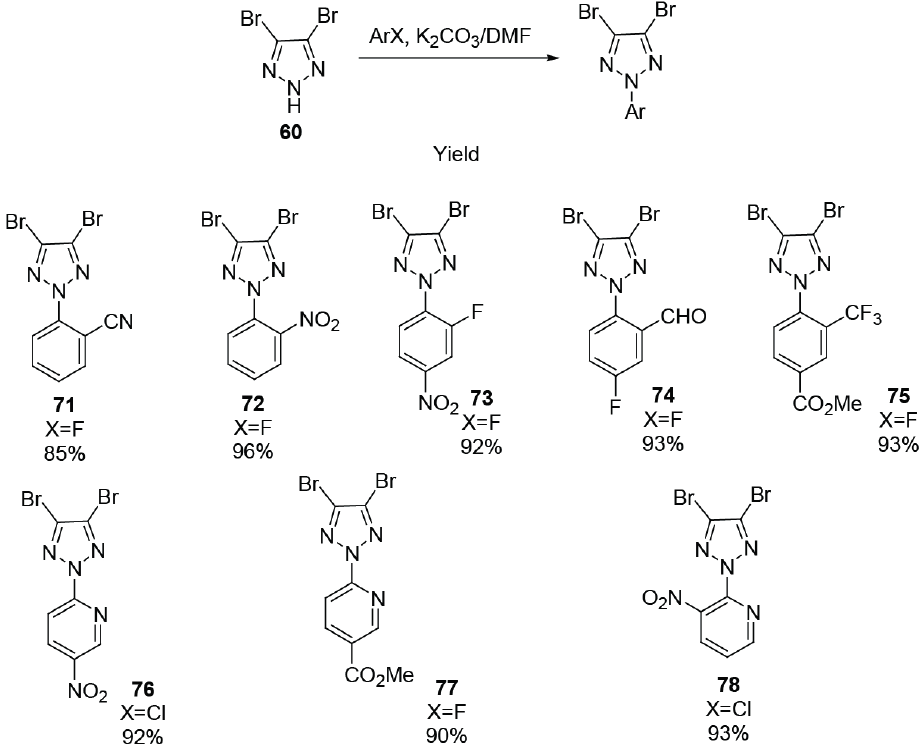
Figure 13 - Arylation of 4,5-dibromo-1,2,3-triazole with electron deficient arenes and